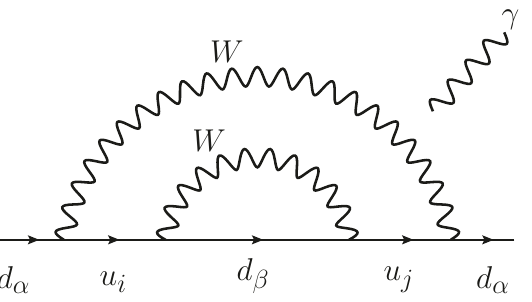
Figure 1 . Two-loop diagram with W boson propagation in the SM. The on-shell photon can couple to arbitrary charged